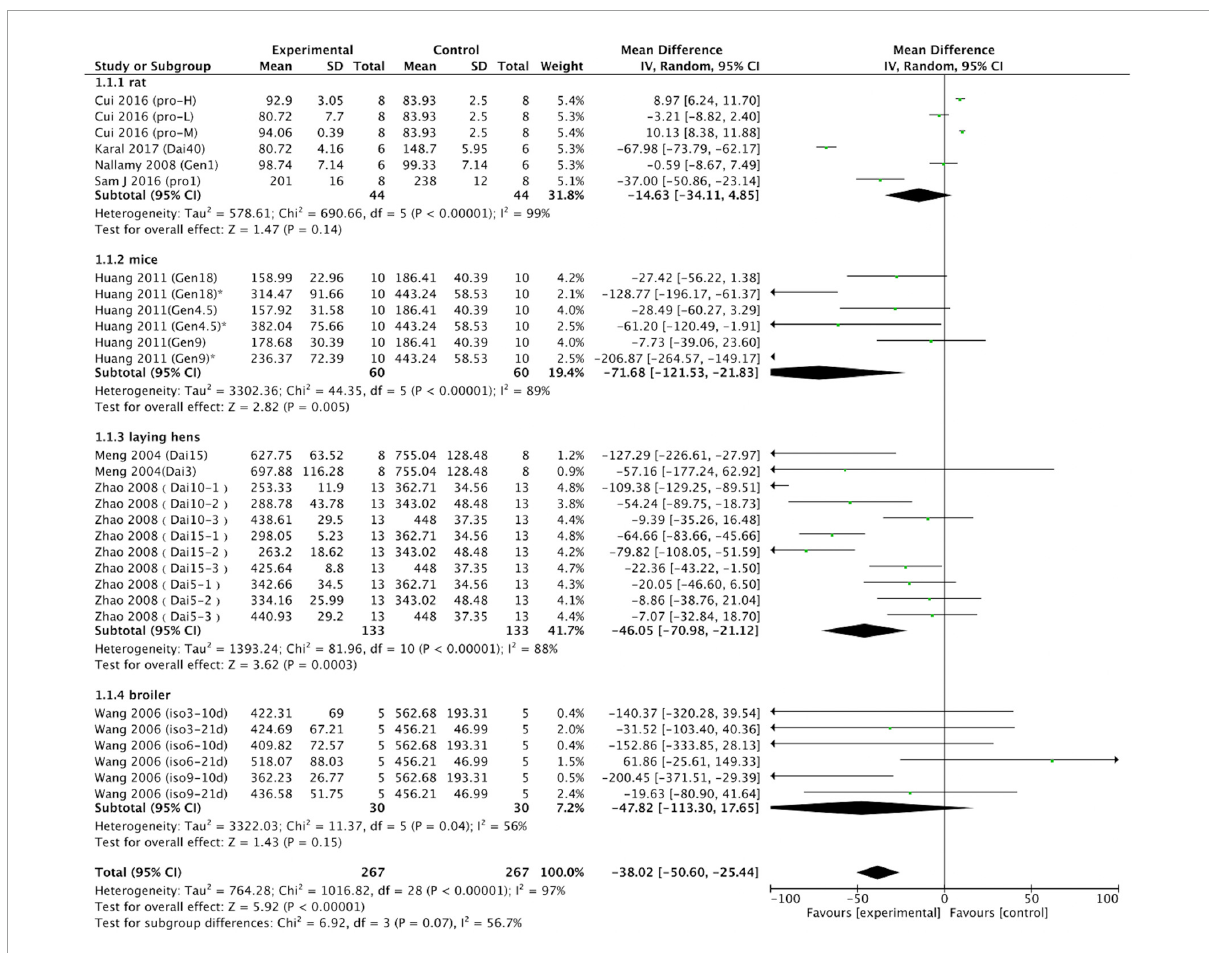
FIGURE6 Forest plot of the effects of soy protein and soy isoflavones on serum and plasma uric acid concentration (grouped by animal species; SD, standard deviation; CI, confidence interval; IV, inverse variance; µ mol/L).